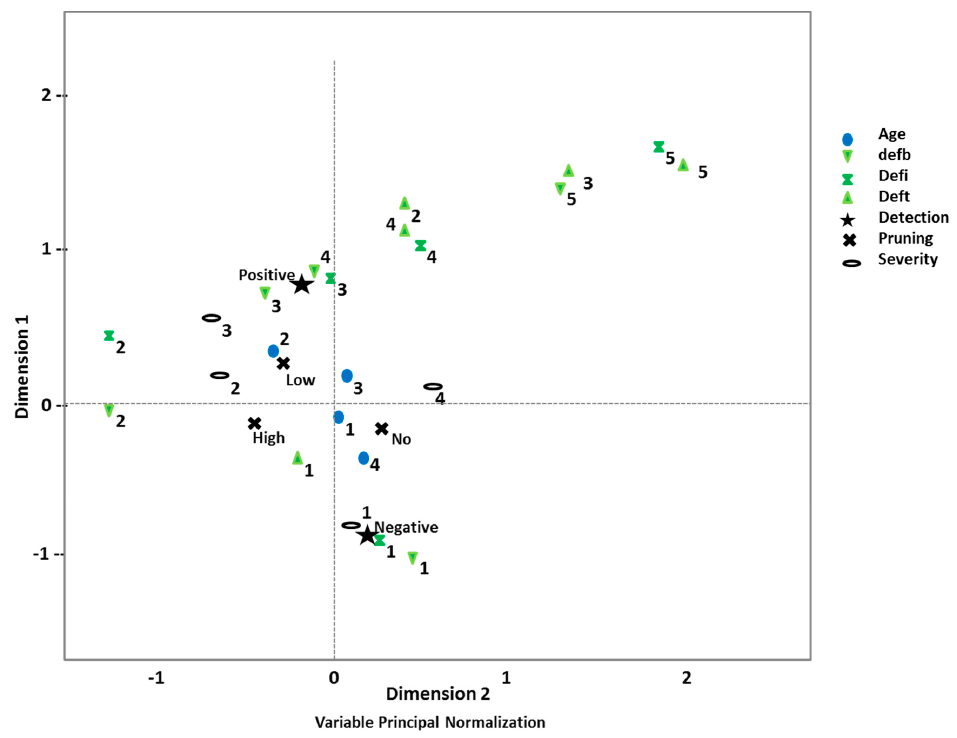
Figure 3. Relationship among fungal infection severity, symptoms, and tree characteristics in the surveyed plantations. Variety and dimensions of dichotomized presence absence of needle pathogenic species, healthy vs. unhealthy, visualized with multiple correspondence analysis and the rest of the variables: Age, defb = defoliation of the tree at the base; defi = defoliation at the middle of the tree; deft = defoliation at the top of the tree; Pruning, severity = severity of the disease. Table 3. Logistic Regression Analysis of disease detection: Factors explaining disease development in plantations of Pinus ( n =